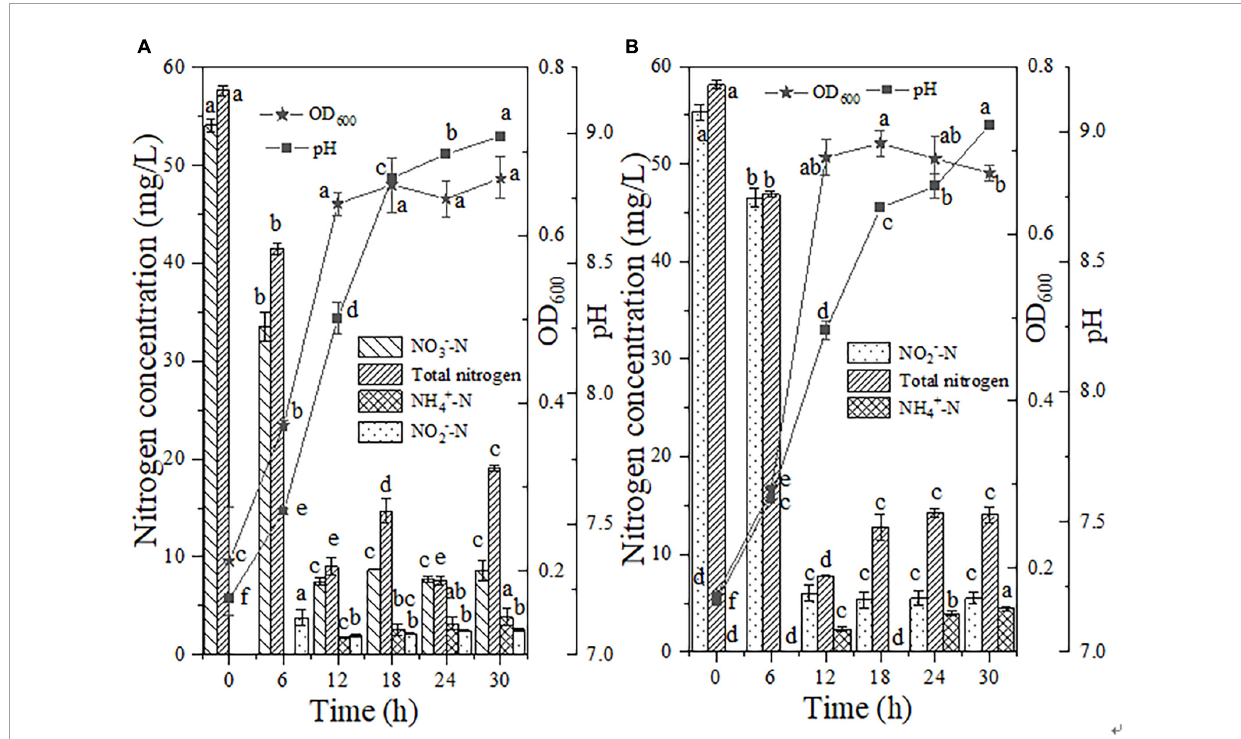
FIGURE4 The aerobic denitrification characteristics of strain EN-J1. (A) Nitrate (NO 3 − -N); (B) nitrite (NO 2 − -N). Different letters represent significant differences between treatments ( p <